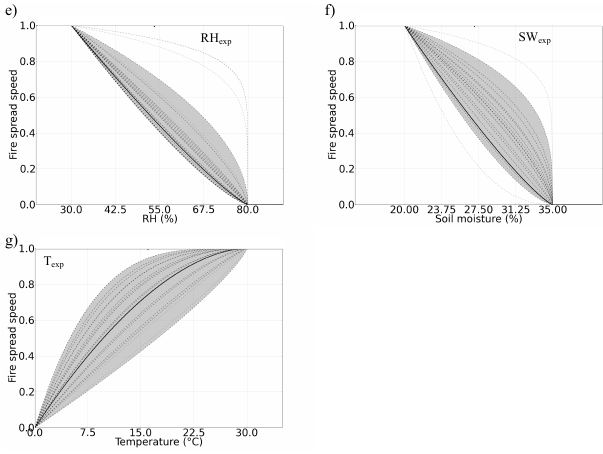
Figure 5. Optimized model parameters and their influence on fire ecology. For each plot, the parameter(s) contributing to the shape of the function are indicated, and the thick black line represents the parameter influence in the final model. The dotted black lines represent the 16 optimization runs that reached a similar parame- terization to the final model, the shaded area showing the range of their influence. The dotted grey lines represent the four optimization runs which reached a parameterization substantially different from the final model (see